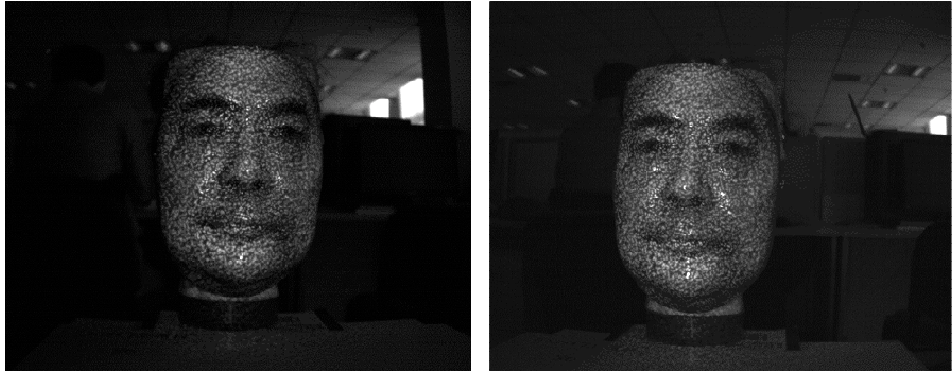
Figure 9. Pairs of infrared image acquired by our device.